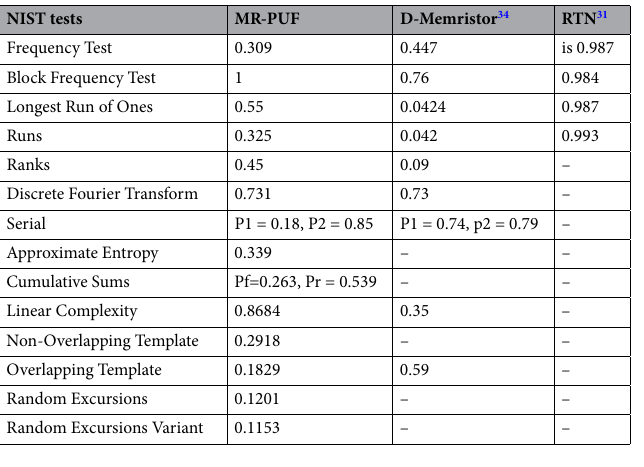
Table 5. Comparison between the proposed Memristor NIST 15 tests’ results and the NIST results of the Memristors presented in literature 31,34 .